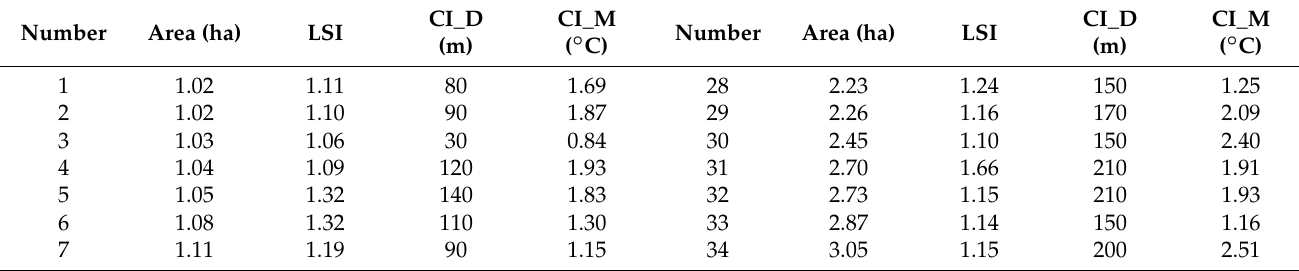
Table A1. Average cooling effect of green